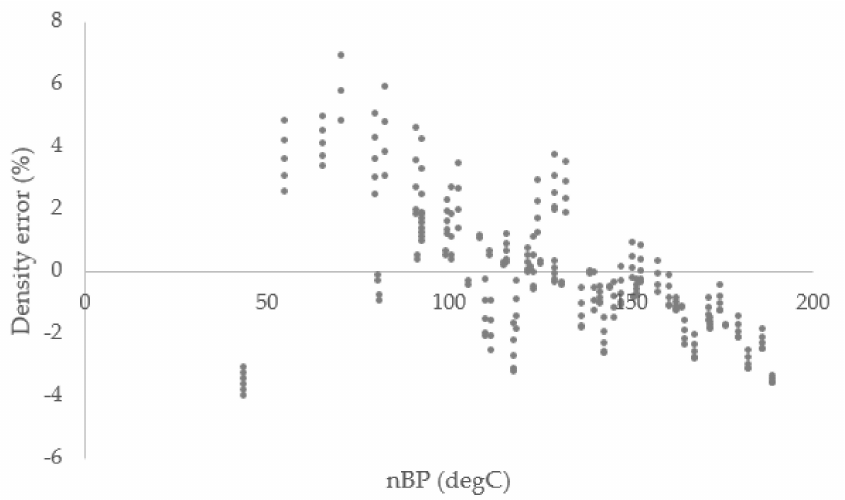
Figure 3. Percent error of the calculated density